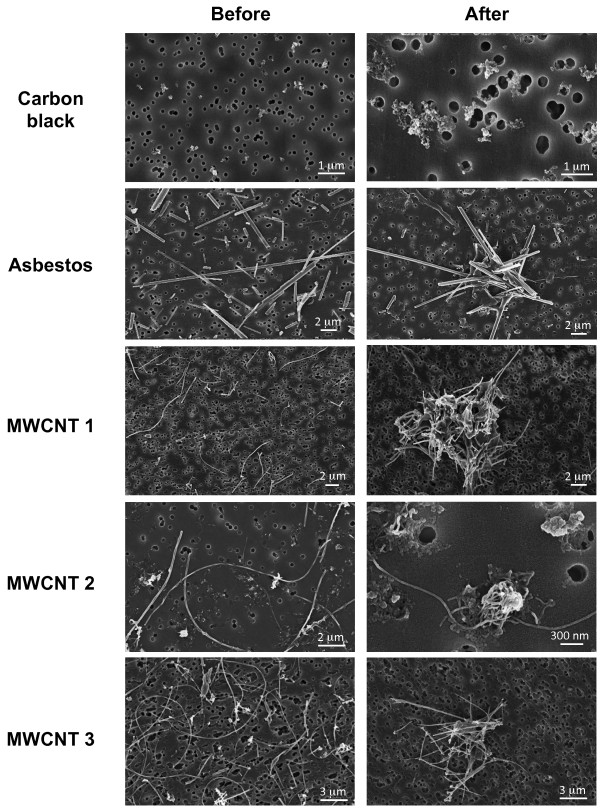
Agglomeration state of particulates before and after exposure. Dispersion of reference and experimental materials in serum-free medium prior to macrophage exposure was evaluated at 5 μg/ml for particles, at 2.5 μg/ml for asbestos fibers, MWCNT 2 and 3, and at 0.5 μg/ml for MWCNT 1. After 14 days of exposure in serum-free medium, 3D cultures were lysed and particulates were recovered and imaged by SEM as described in Materials and Methods. Limited agglomeration of carbon black particles is evident in comparison with larger agglomerates of asbestos and MWCNTs post-exposure.